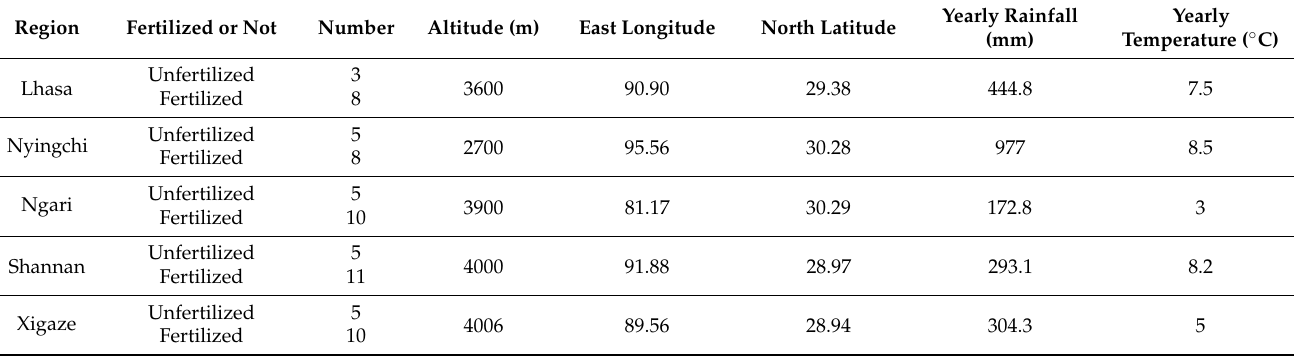
Table 1. Information on highland barley samples from five regions of